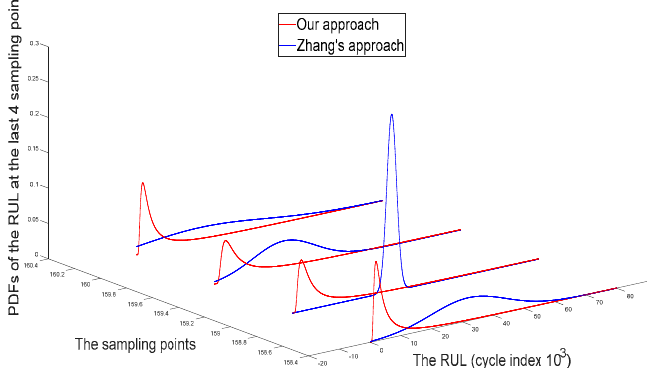
Figure 11. The comparison chart.